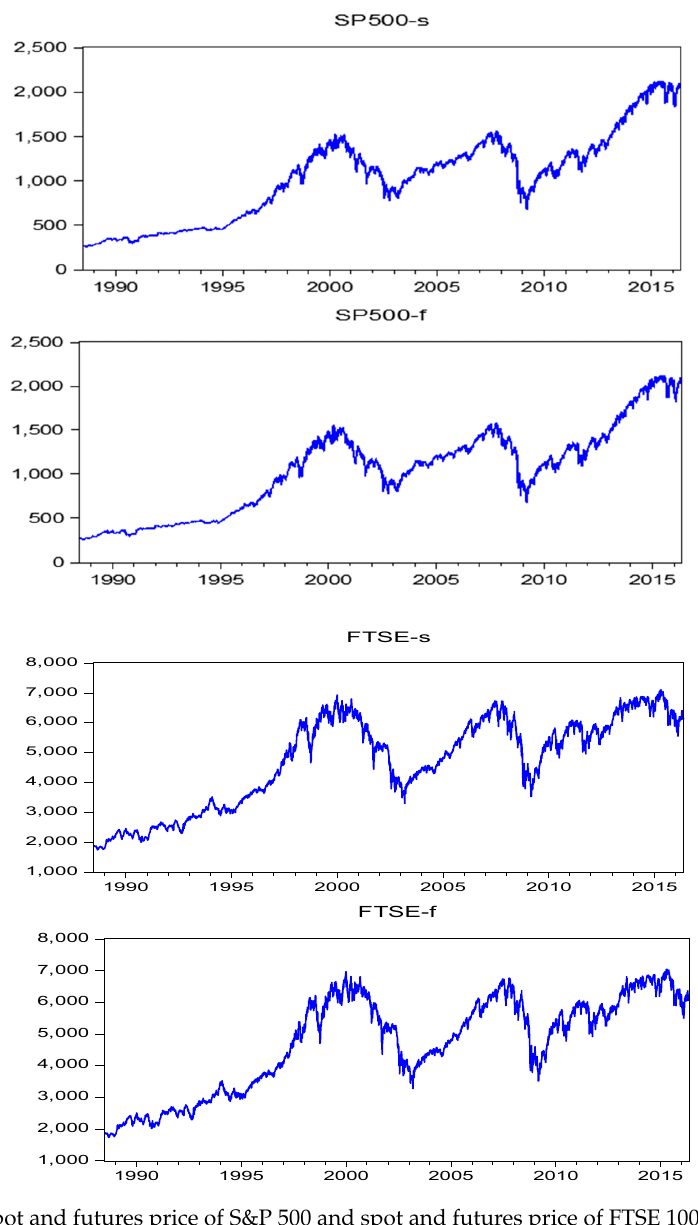
Figure 2. Spot and futures price of S&P 500 and spot and futures price of FTSE 100, 1988–2016.